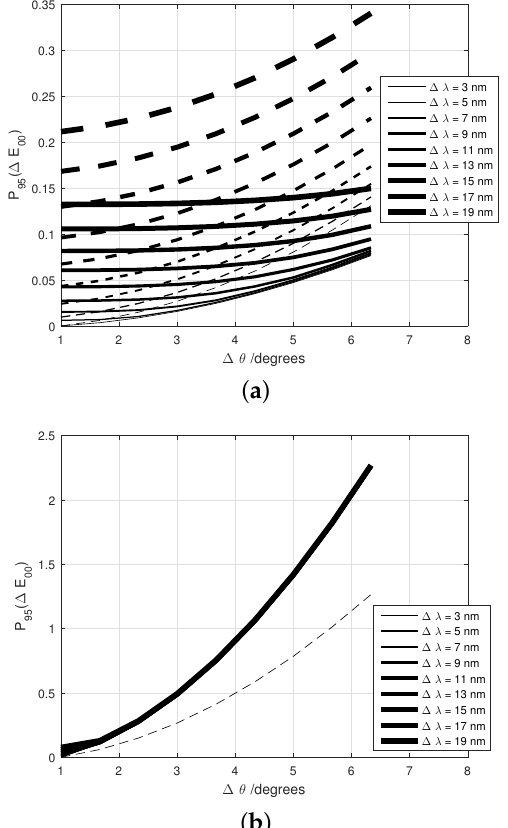
Figure 6. Colour-difference descriptors, P 95 ( ∆ E 00 ) , obtained in this study for ( a ) interference- and ( b ) diffraction-based special effect coatings. Two highly goniochromatic coatings of each type are represented, identified by solid and dashed line ( a ) Interference-based special effect coatings (Colorstream R (cid:13) T20-04 WNT Lapis Sunlight (solid line) and Colorstream R (cid:13) T20-02 WNT Arctic Fire (dash line)); ( b ) Diffraction-based special effect coatings (SpectraFlair R (cid:13) Silver 1500-35 (solid line) and SpectraFlair R (cid:13) Plus 25 (dash